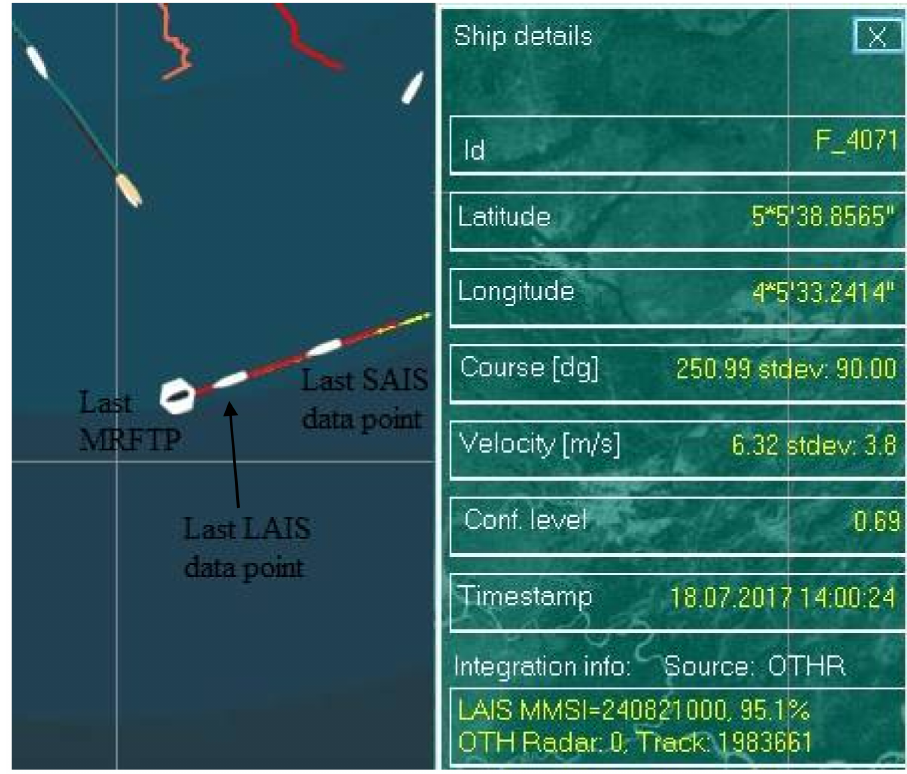
Figure 8. Land automatic identification system (LAIS) and satellite automatic identification system (SAIS) data latency (red trace: MRFT data, yellow trace: AIS